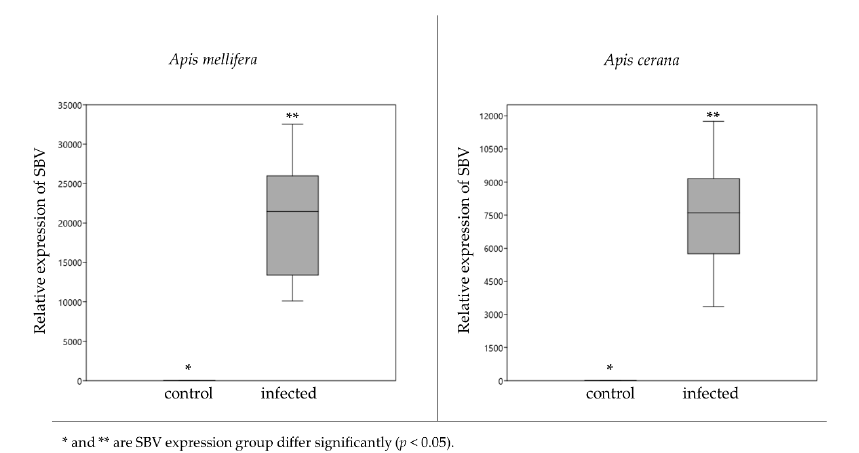
Figure 1. Relative expression of Sacbrood virus (SBV) boxplot showing the level of SBV detection in the control bees and infected larvae. SBV in the infected larvae is detected at significantly higher levels than in the control larvae, for both A. mellifera (t = 6.40, df = 10, p = 0.001) and A. cerana (t = 6.77, df = 10, p = 0.001).